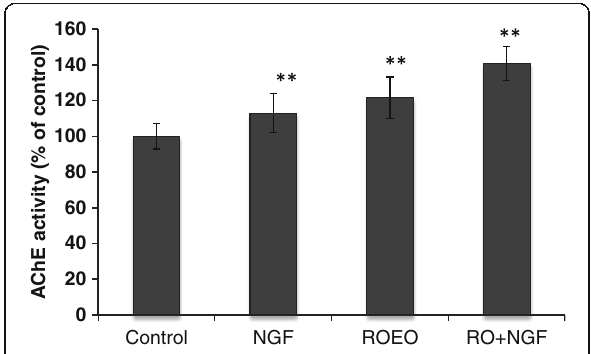
Fig. 4 Effect of Rosmarinus officinalis essential oil (ROEO) on acetylcholinesterase (AChE) activity in differentiated PC12 cells. PC12 cells were seeded onto 96-well plates at a density of 1×10 5 cells/ml and were pre-treated with 50 ng/ml nerve growth factor (NGF) for 24 h before treatment with 10 μ g/ml of ROEO for 48 h without (ROEO) or with 10 ng/ml NGF (RO+NGF). AChE activity was expressed as percentage of control. Data are presented as a percentage of the control and represent the mean of three independent trials ±.SD * P ≤ 0.05, ** P ≤ 0.01 vs.